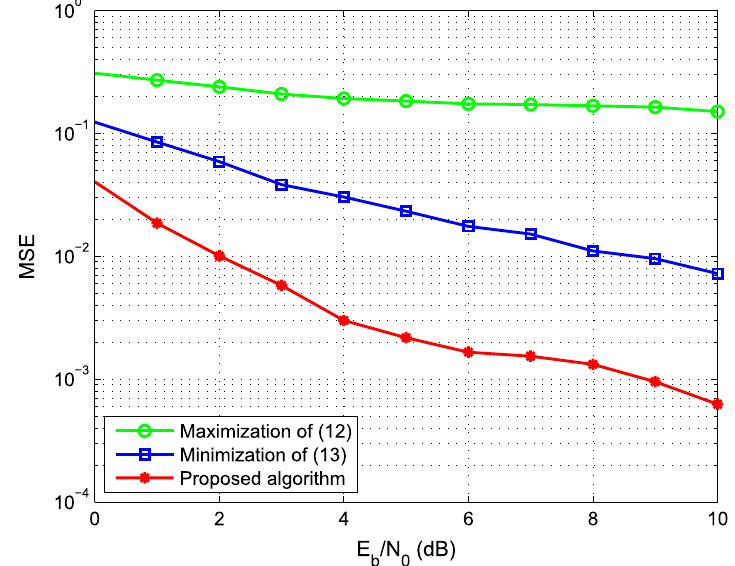
Fig. 4 MSE curves of the proposed algorithm applied to an LDPC code of length n = 512 bits, rate R = 1 / 2 and u i =